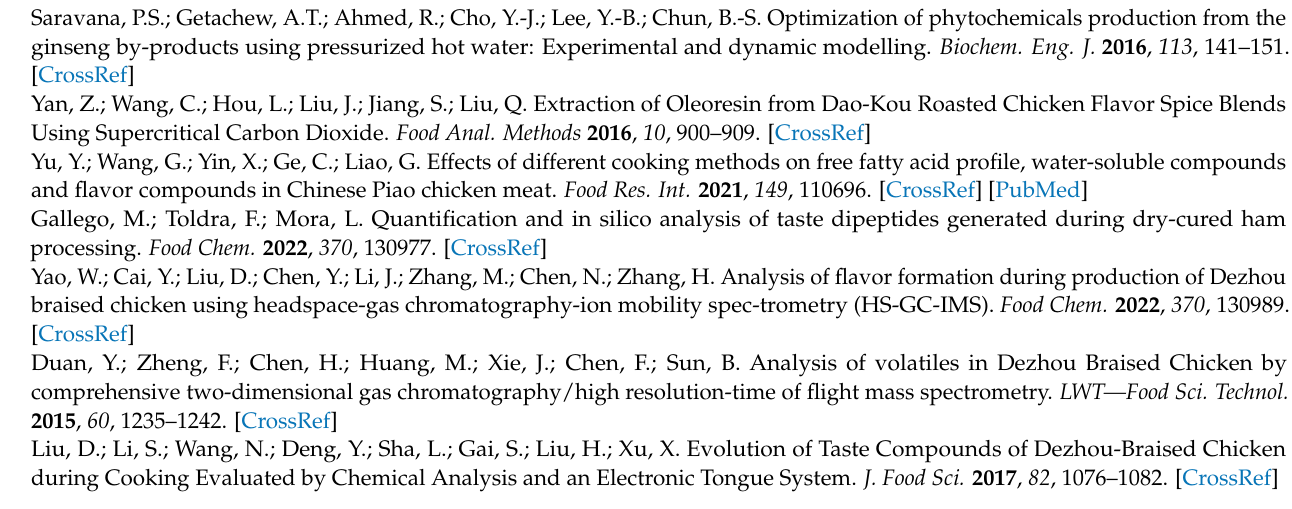
Figure; L.S.: Methodology, Writing—original draft, Writing—review and editing; G.Z.: Writing— review and editing; C.Z. and M.L.: project administration, Writing-review. All authors have read and agreed to the published version of the